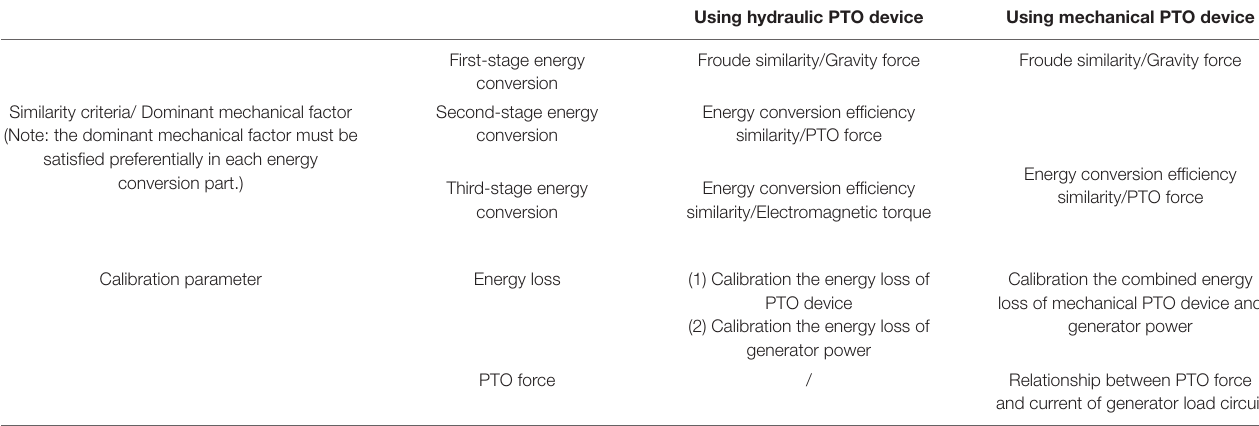
TABLE 2 | Scaling orchestration of the oscillating buoy